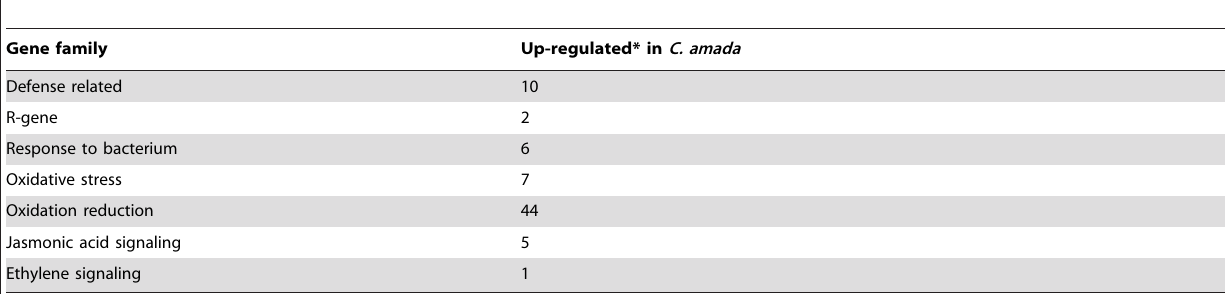
Table 2. Summary of genes with high expression levels in response to R. solanacearum in C. amada, listed according to function.